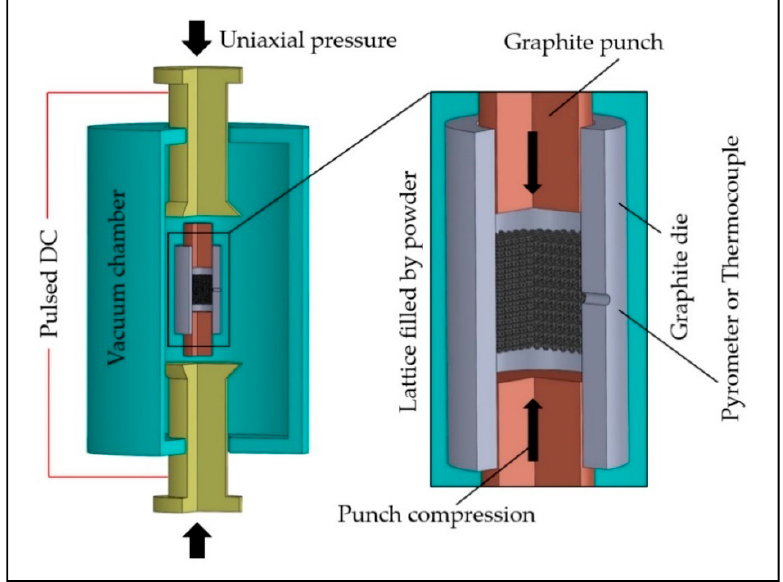
Figure 1. Schematic of spark plasma sintering device (SPS, SolidWorks design).